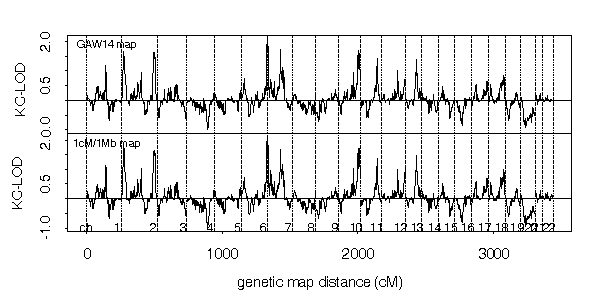
K-C LOD scores for NPLall for the Illumina SNP markers. Two sets of results are included: one using the genetic map given by GAW14 and another using the map derived from the 1 Mb-to-1 cM rule.